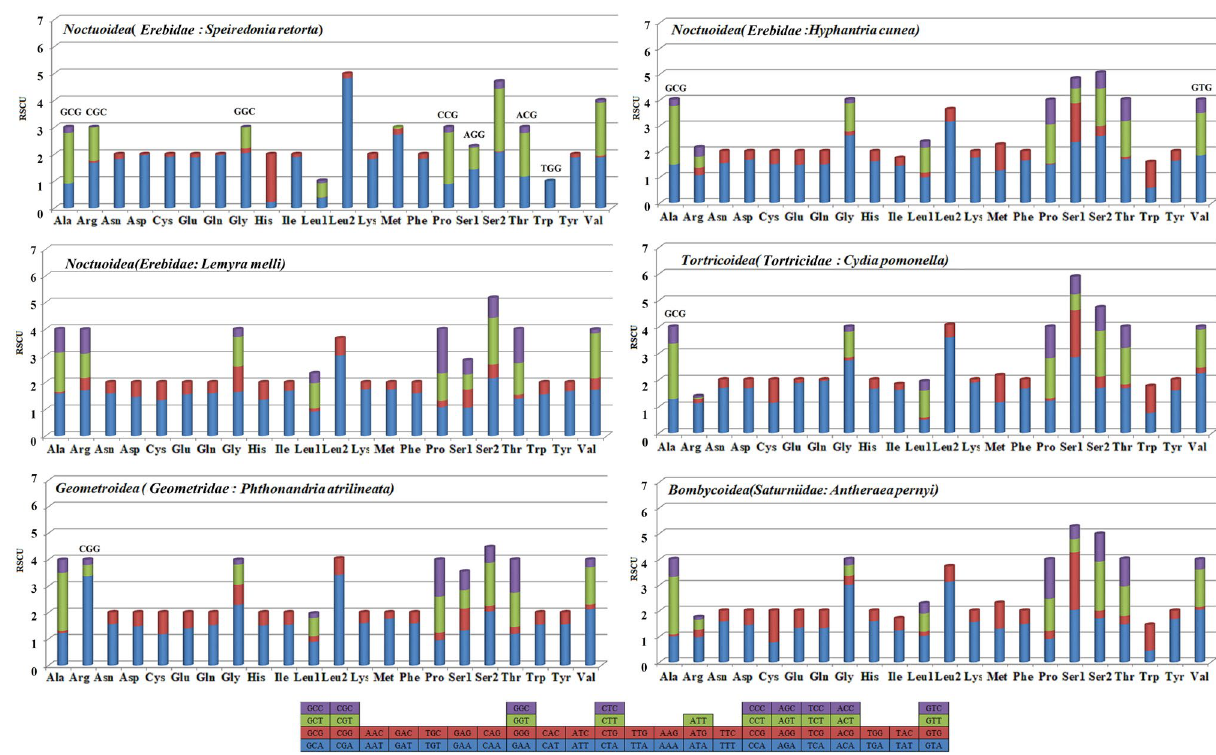
Figure 4. Mitogenome Relative Synonymous Codon Usage (RSCU) for the four Lepidopteran superfamilies, with codon families on the x -axis. Any codons above the bar were absent within the mitogenome.